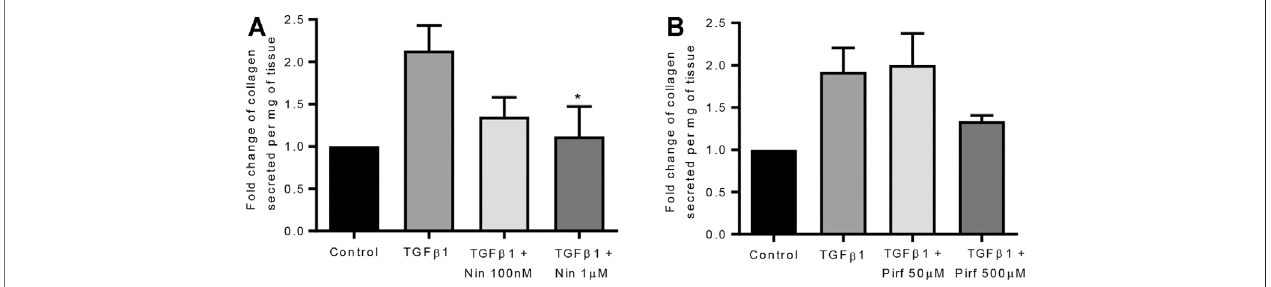
FIGURE 8 | The effects of nintedanib and pirfenidone on soluble collagen secretion. (A) Nintedanib inhibited TGF β 1-dependent soluble collagen secretion into the supernatants following 4 days of ex vivo culture ( n (cid:1) 5, p (cid:1) 0.040) (Data are presented as mean ± SEM * p < 0.05, paired t test). (B) Pirfenidone did not signi fi cantly attenuate soluble collagen secretion into the supernatants following 4 days of ex vivo culture ( n (cid:1) 5). The amount of collagen secretion was examined per mg of tissue present in the well.